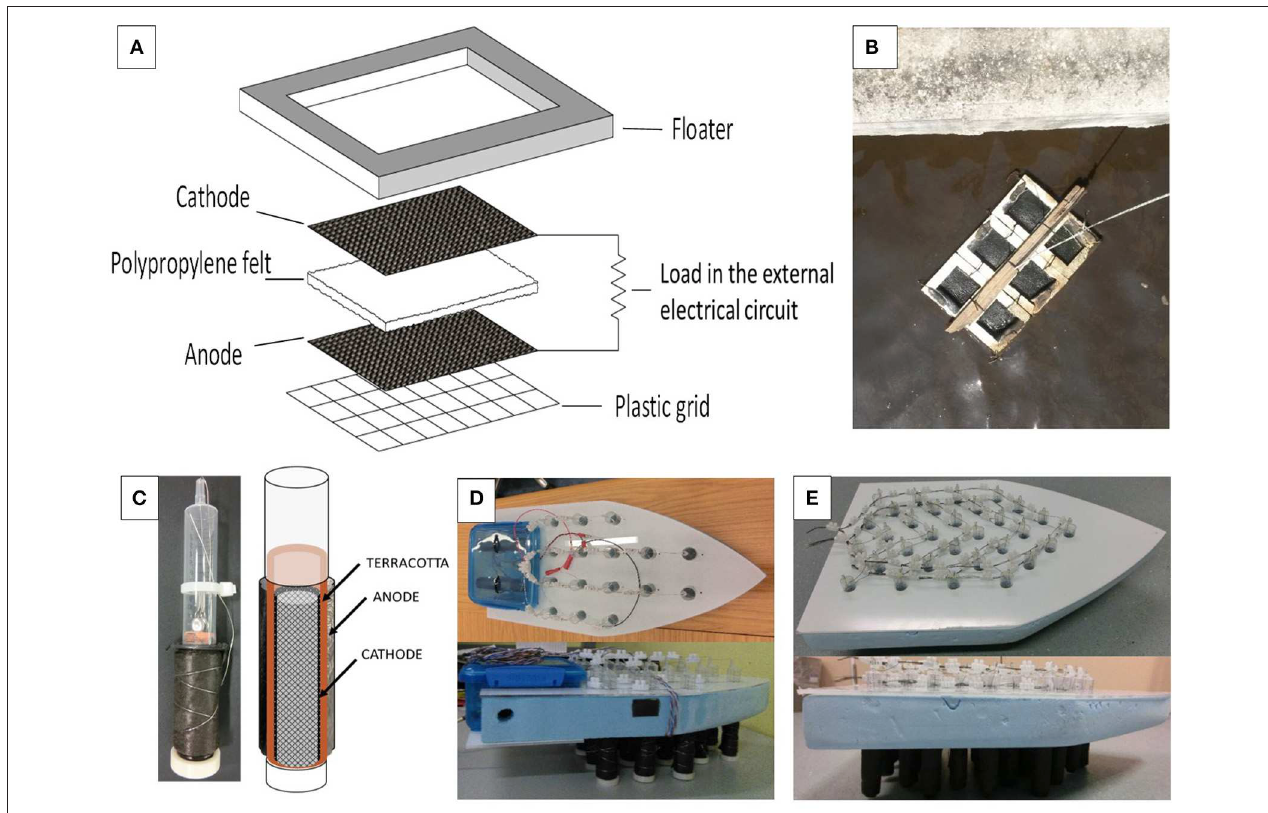
FIGURE 1 | Scheme of a flat MFC (A) and set-up of six MFC elements in a frame ready for the immersion in wastewater (B) . Single tubular MFC element and its scheme (C) . Tubular MFC elements integrated into a styrene boat: small boat with 16 elements (D) ; large boat with 32 elements (E)